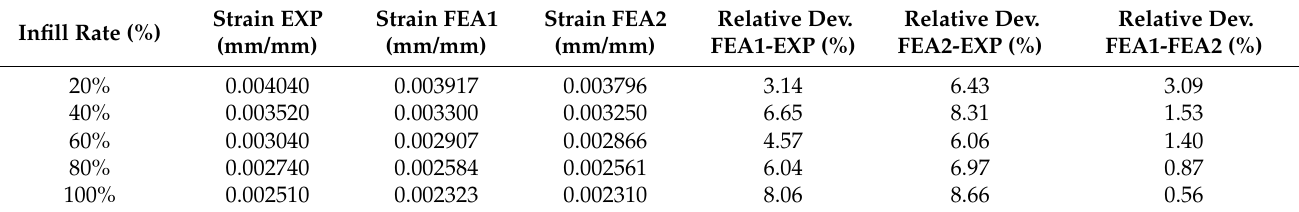
Table 1. Comparison of the displacements from experimental tensile test (EXP) to simulation results with two different element lengths (FEA1 &